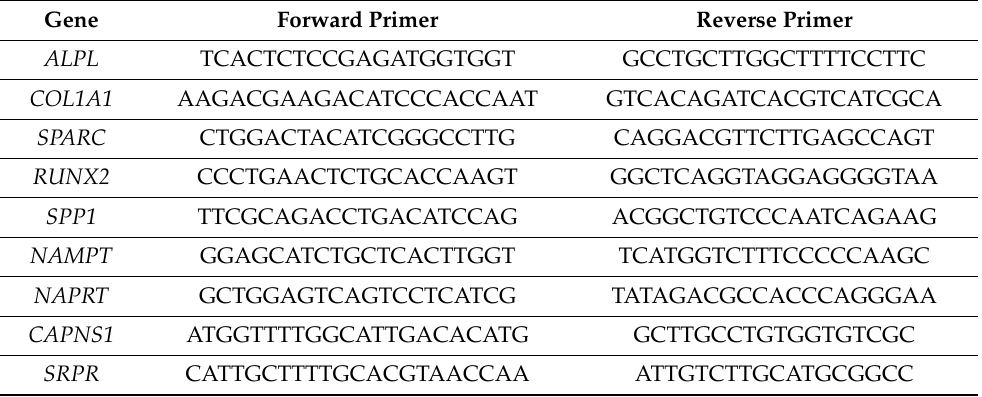
Table 1. List of primer sequences used in this